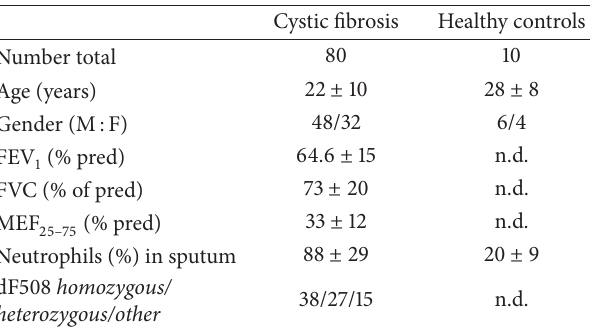
Table 1: Patient characteristics. Cystic